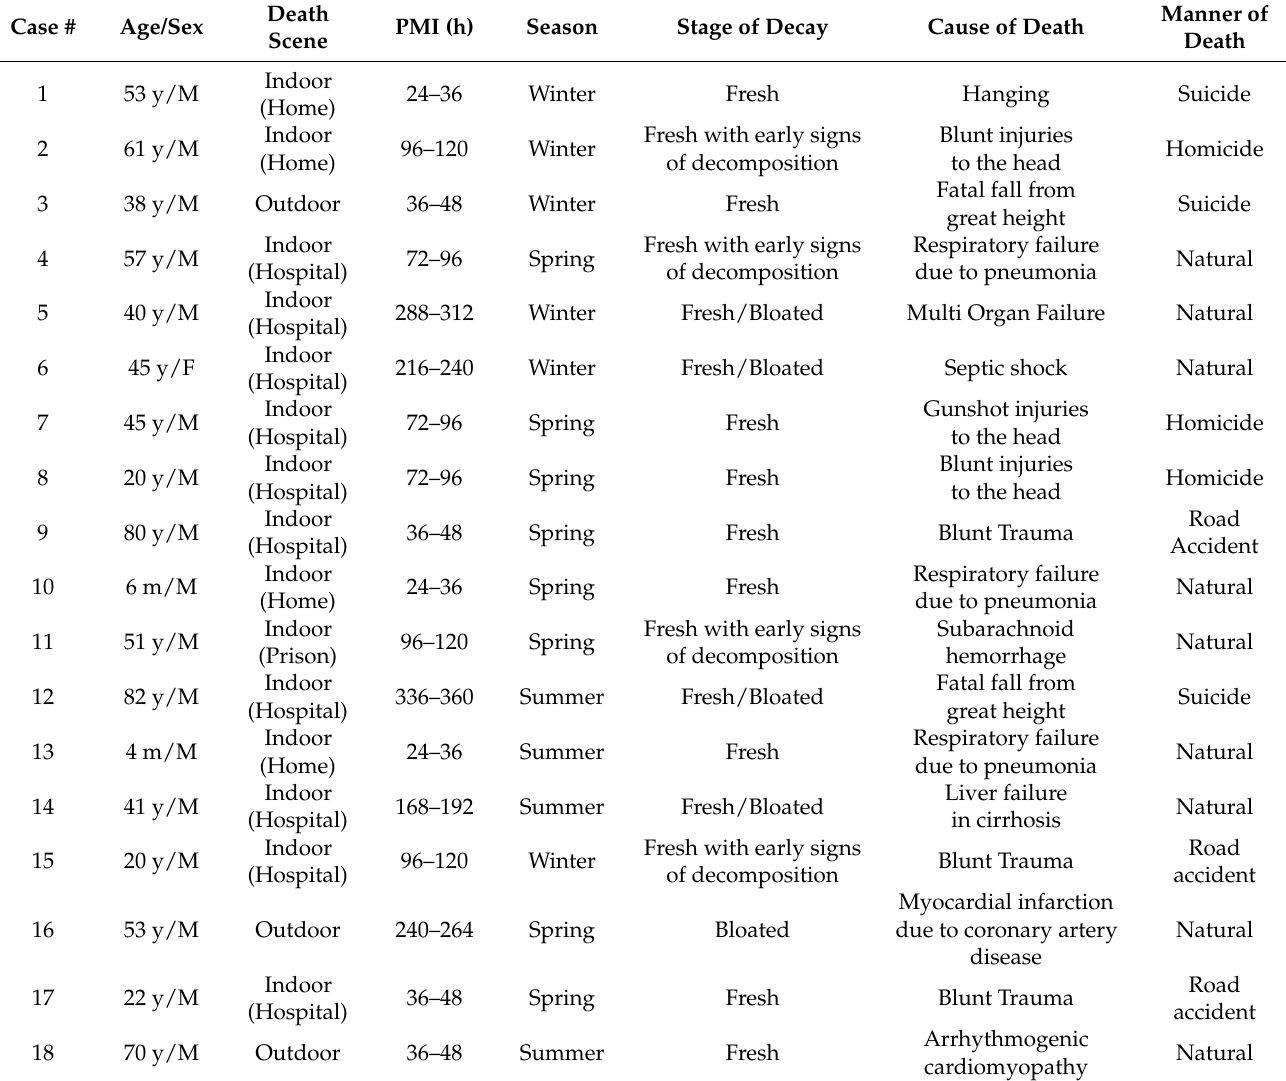
Table 1. The study group represented by 18 bodies with details of each case regarding sex, age, death scene, PMI, stage of decay, manner, and cause of death. Legend: y: years; m: months; M: male; F: female; h: hours; PMI: post-mortem